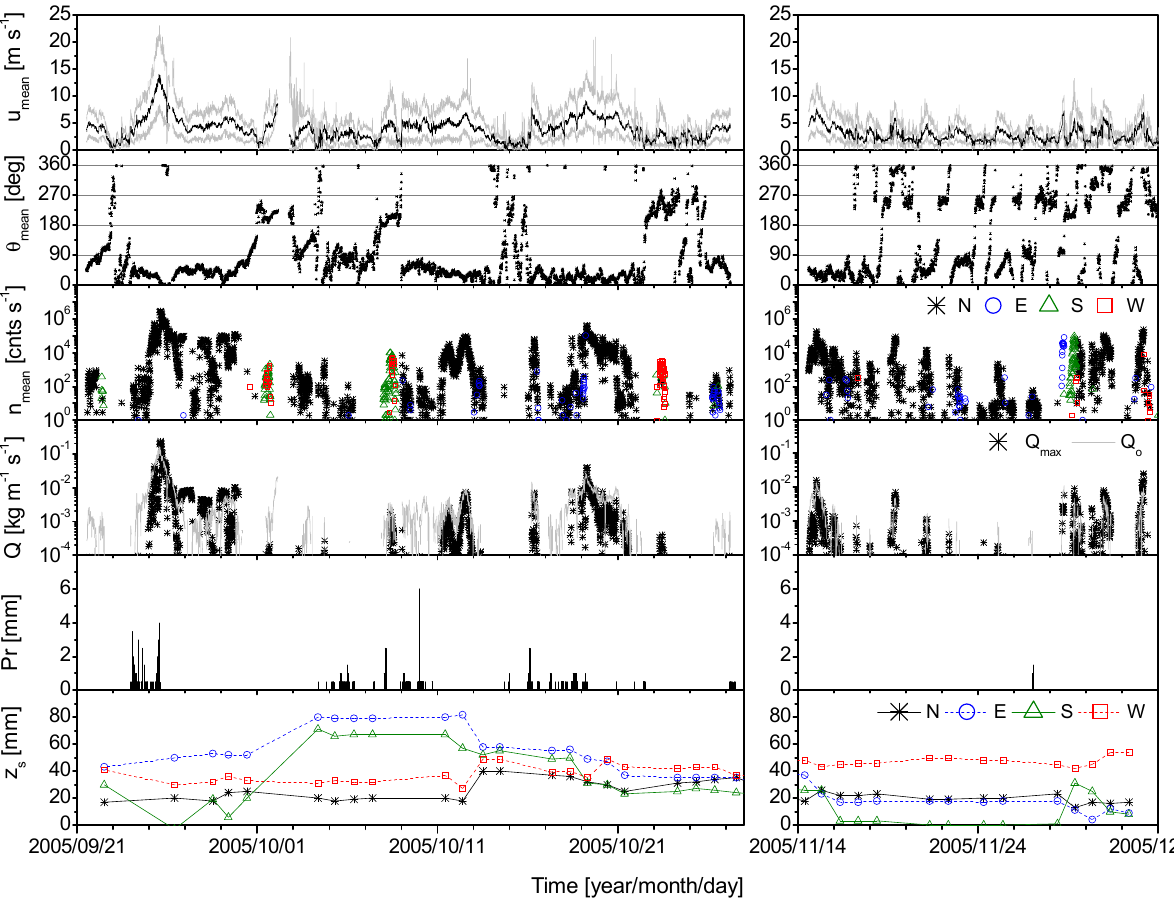
Figure 6. Time series of 10-min averages of the horizontal wind velocity u , horizontal mean wind direction θ , blown-sand impact count n , estimated total aeolian sand flux mean mean Q , and precipitation Pr ; the time series of Q estimated from Equation (13) and the mean O are also shown. The solid gray lines in the daily sensor height from the ground surface z s top figure show the maximum and minimum instantaneous wind velocities. The wind direction is expressed clockwise from north, from 0° to 360°. Only the maximum n for mean the four directions in each of the 10-min intervals is